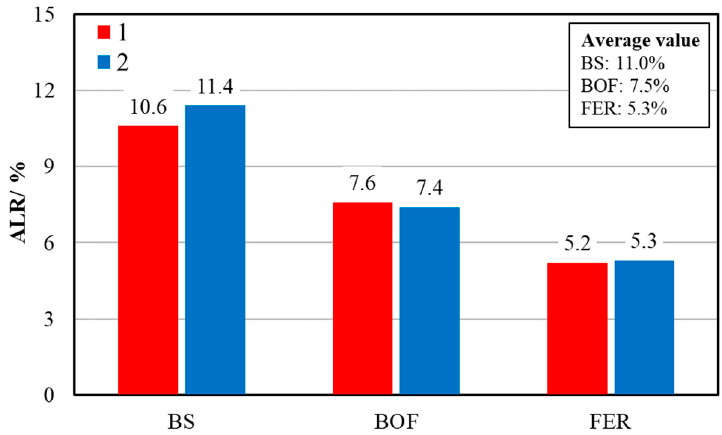
Figure 11. Aggregate loss rate of different chip seal samples.